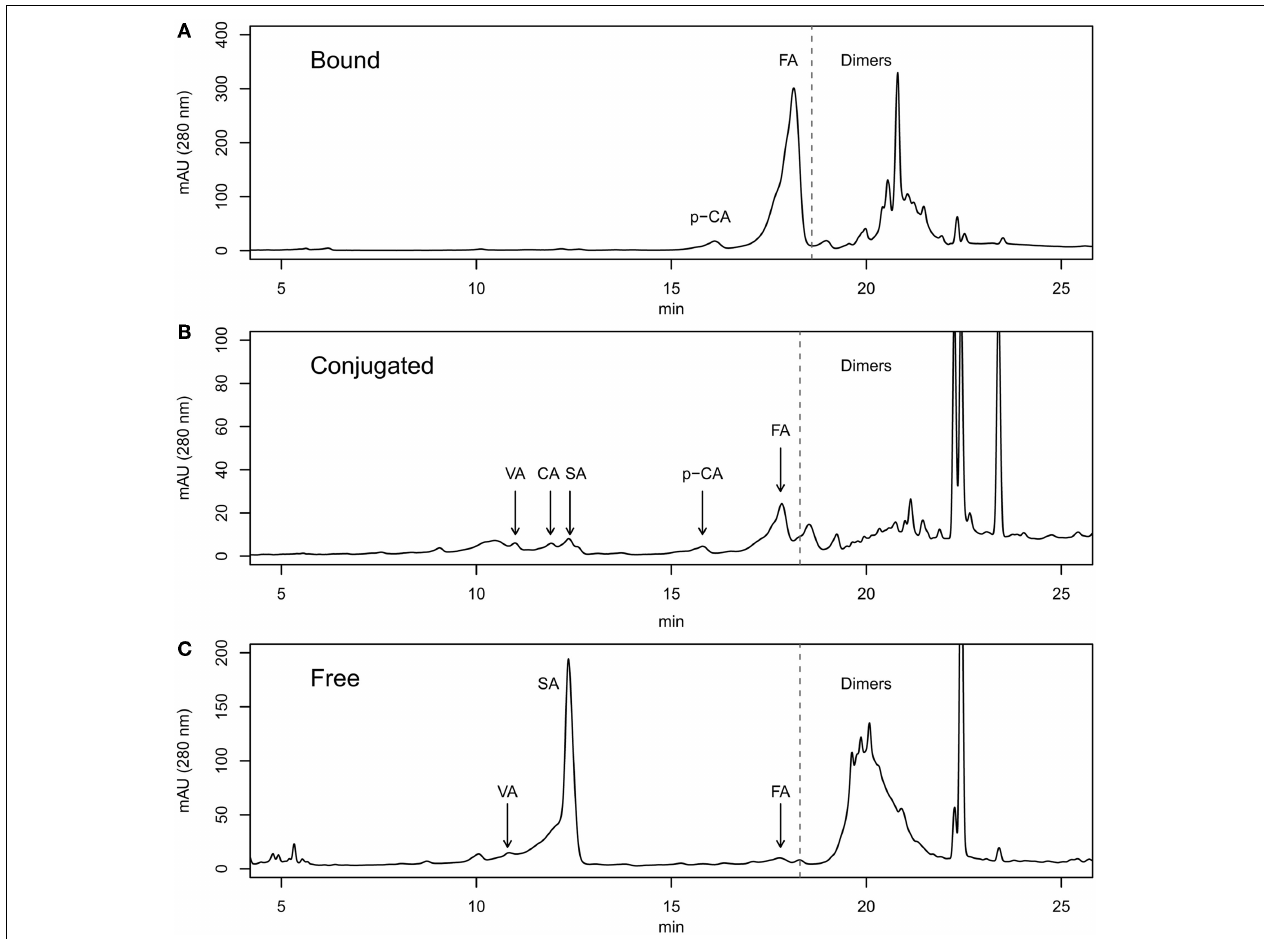
FIGURE 1 | RP-HPLC chromatograms of the bound (A), conjugated (B), and free (C) phenolics fractions from tritordeum